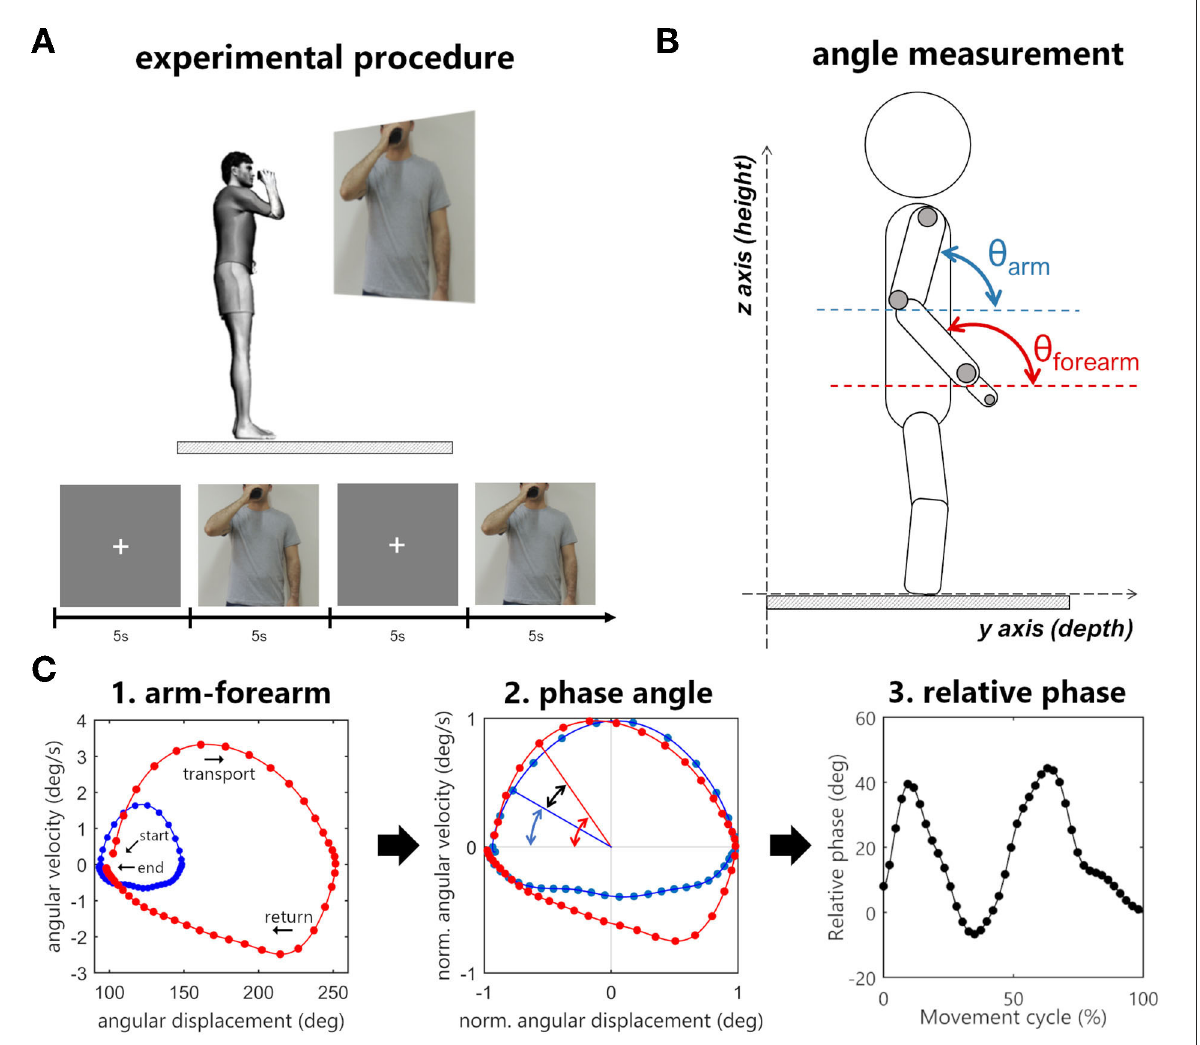
FIGURE1 (A) Experimental procedure. The sequence of images consisted of a fixation cross and a picture of a person holding a cup in front of the mouth. When the movement image was displayed, participants had to immediately bring the cup to the mouth and then return to the standby position. (B) Angle measurement in sagittal plane. (C) Arm–forearm dynamics analyzed during the cycle of transporting the cup to the mouth and returning to the standby position (blue points: arm, red points: forearm). (C1) Starting and ending points of the full cycle are signalized by arrows. The evolution is seen in a clockwise direction. The points in the graph represent the angular displacement ( θ ) and the angular velocity ( ω ) of a segment in a time instant. (C2) The difference between the normalized phase angles (black arrow) is the relative phase (RP = 8 Forearm – 8 Arm). (C3) The relative phase over